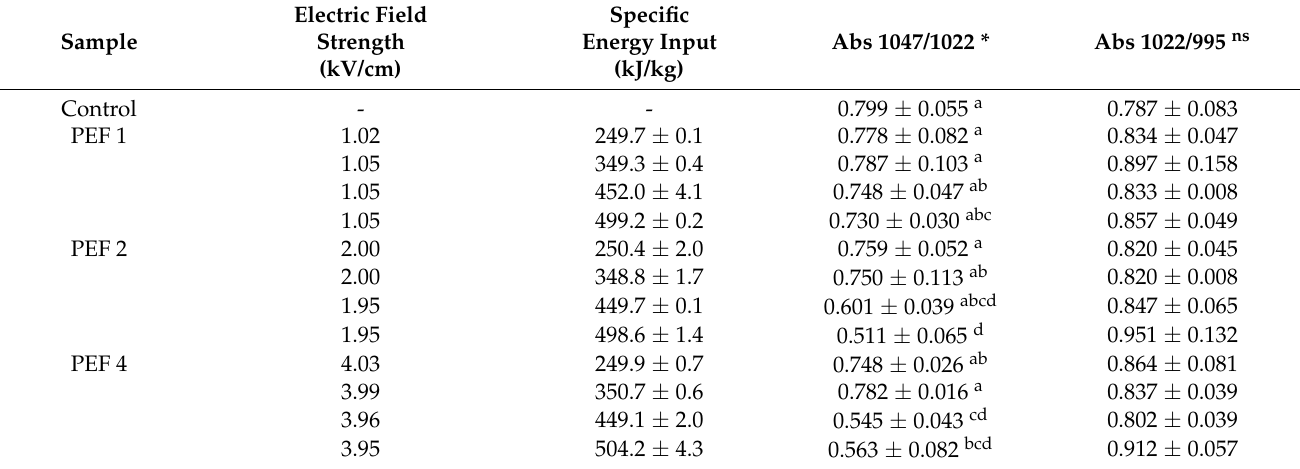
Table 3. Absorbance ratio values of control (untreated) and PEF-treated cassava flours.